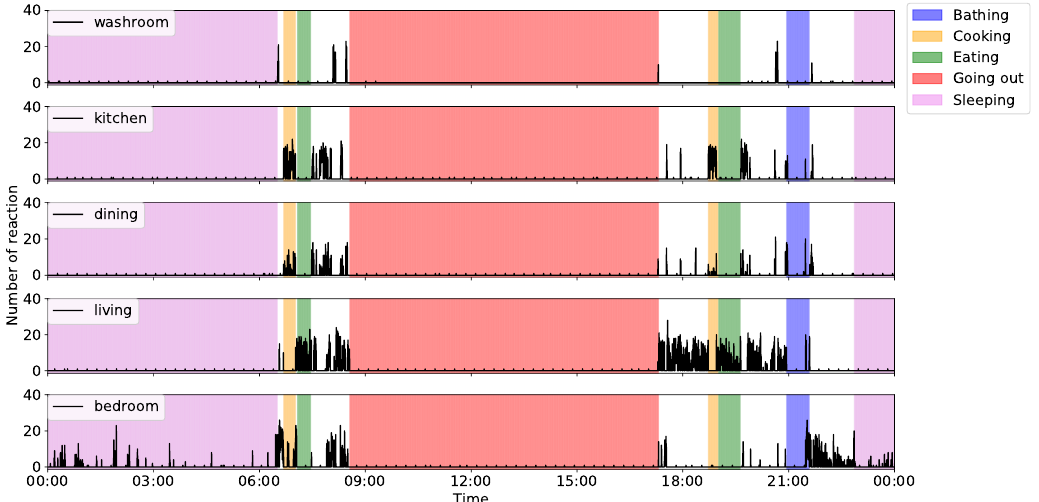
Figure 6. Example of collected activity of daily living (ADL) data (motion sensor).